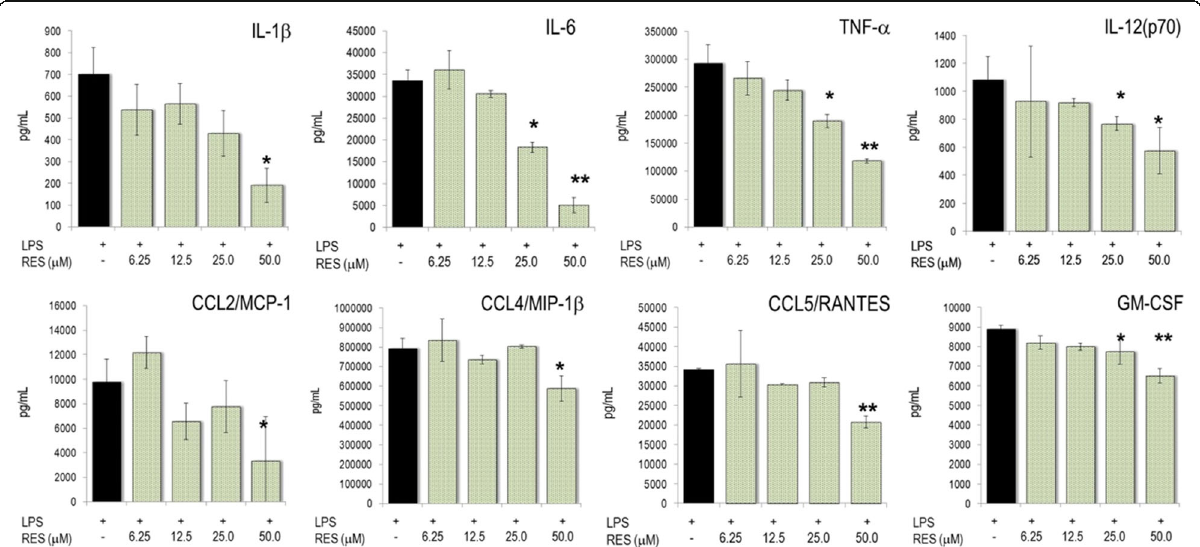
Fig. 1 RES modulated cytokine and chemokine production in RAW264.7 cells. Cells were incubated with different concentrations of RES, stimulated with 1 μ g/mL LPS and cultured for 24 h. The mediators were determined in cell culture supernatants. Results are shown as mean (± SEM) of triplicate cultures of three experimental series. * p < 0.05, ** p < 0.01 (versus LPS-stimulated cells)